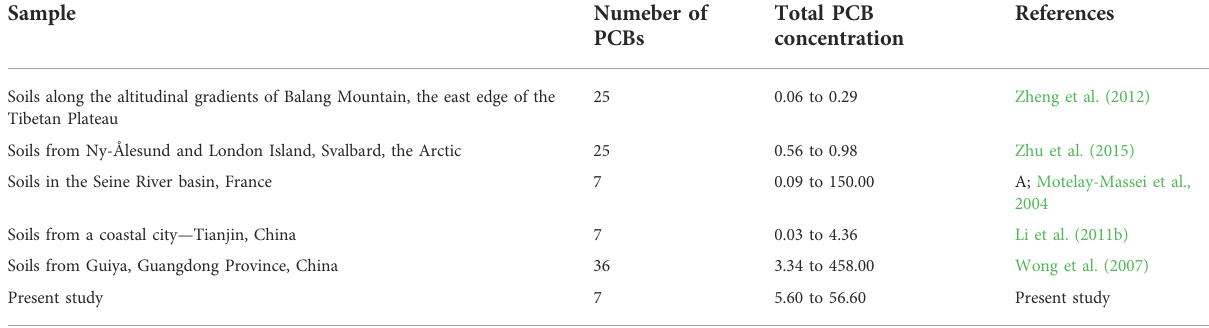
Table 4. The concentrations of total PCB in the thirty-seven soil